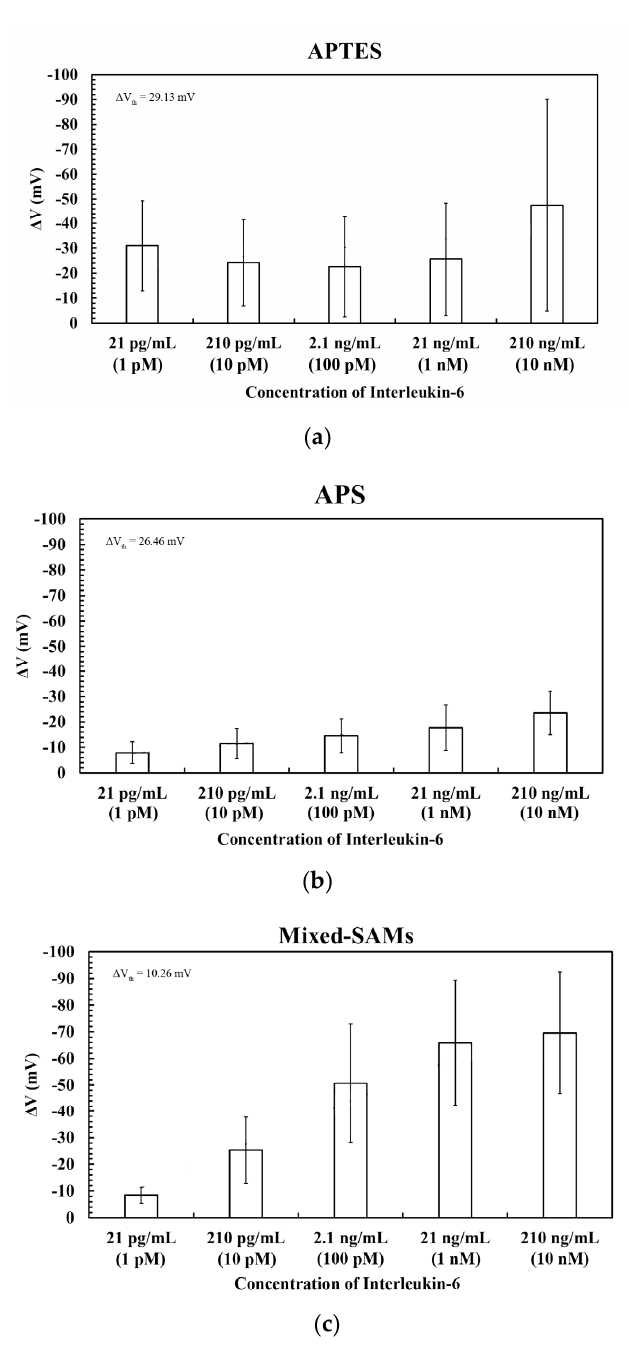
Figure 5. Detection of IL-6 on the SiNW-FETs by using the antibody. These experiments were performed on three modified layers upon the device surfaces: ( a ) APTES-GA-Ab layer, ( b ) APS-GA-Ab layer, and ( c ) mSAMs-GA-Ab layer. The threshold values, Δ V th , are denoted in the figures.